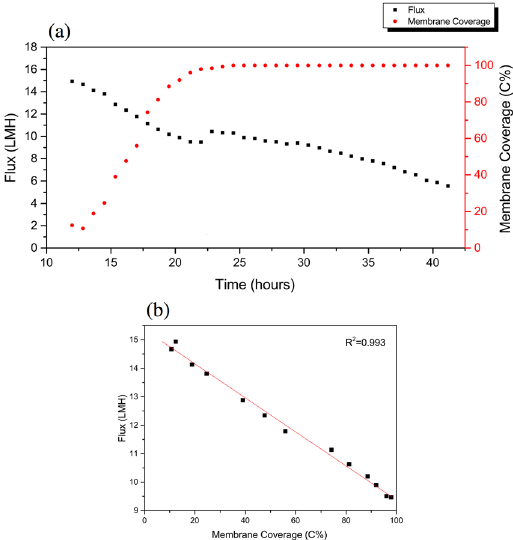
Figure 3. ( a ) The relationship between membrane coverage and permeate flux in the function of filtration time. ( b ) Correlation between membrane coverage and permeate flux (Phase I: from 12 to 22